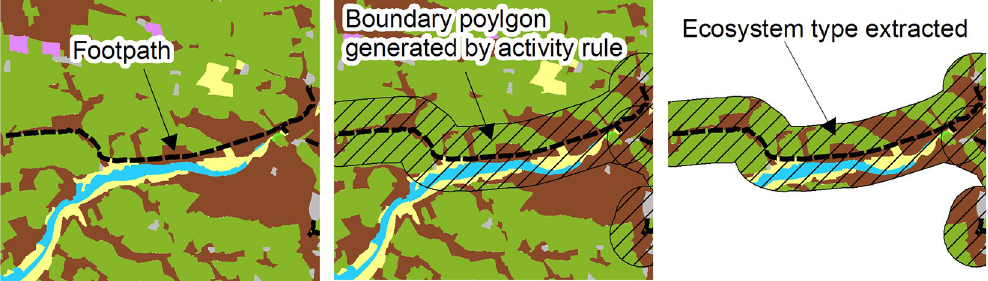
Fig 3. Extracting ecosystem type. Panels from left to right detail how the ecosystems contributing to activity were identified and their area